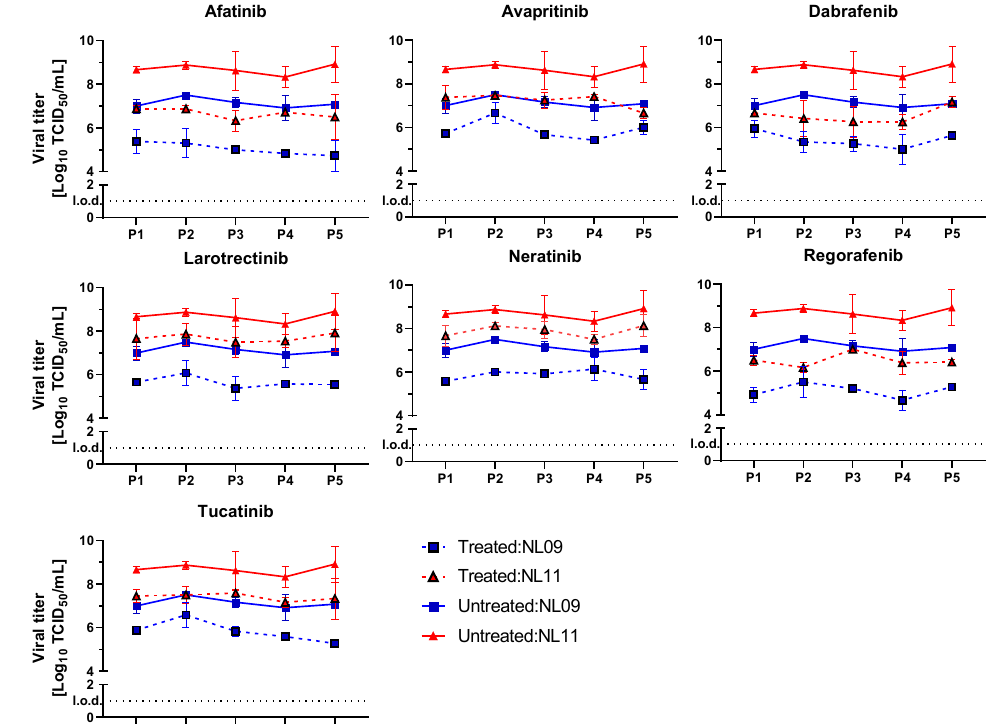
Figure 7. SMKI inhibition of IAV is maintained over serial passaging . The stability of SMKI treatment on NL09 and NL11 replication was determined by five serial passages on MDCK cells infected at MOI = 0.001 for 72 h in the presence of the [1×] max SMKI concentrations ( n = 4) at each passage. At each passage, viral titers were quantified to inoculate the next passage at the same MOI; means ± SDs are shown. l.o.d.: limit of detection.